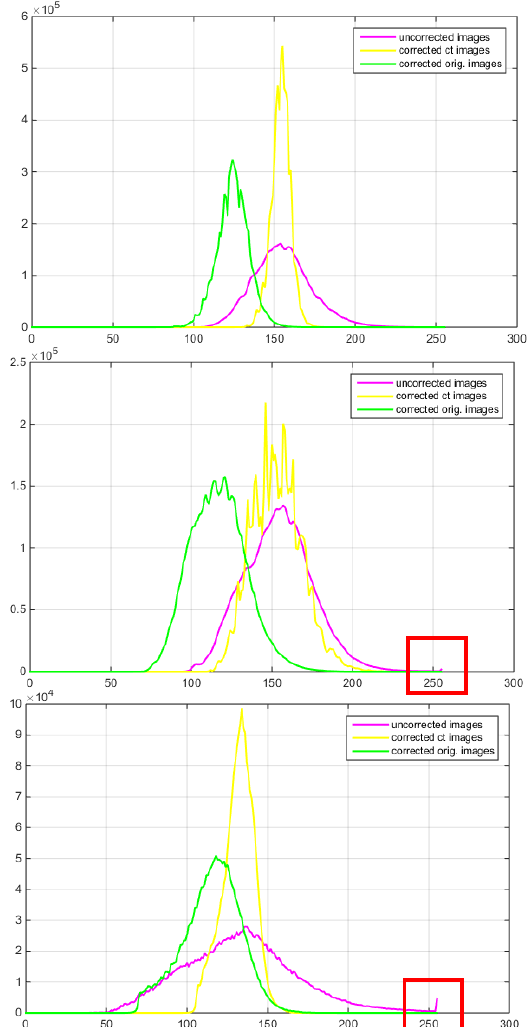
Figure 4. The respective histograms of the example images presented in Figure 3.